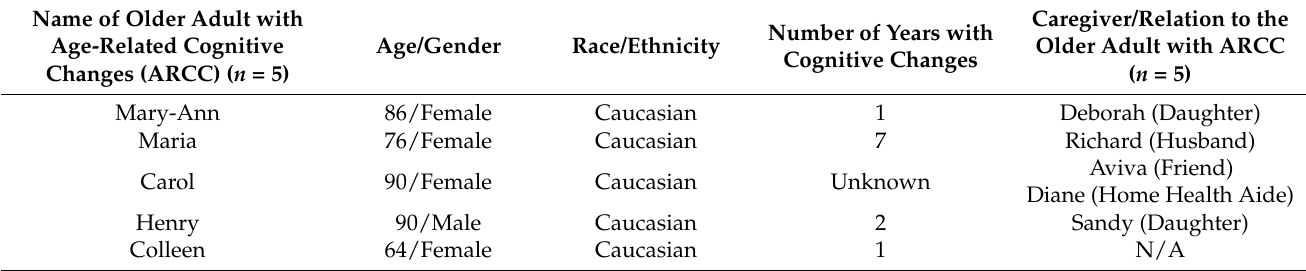
Table 1. Participant Characteristics ( n =